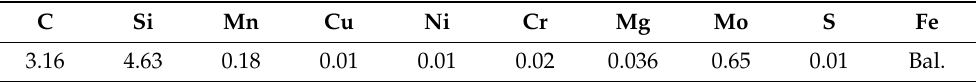
Table 1. Chemical compositions of EN-GJS-SiMo45-6 alloy (wt. %). C Si